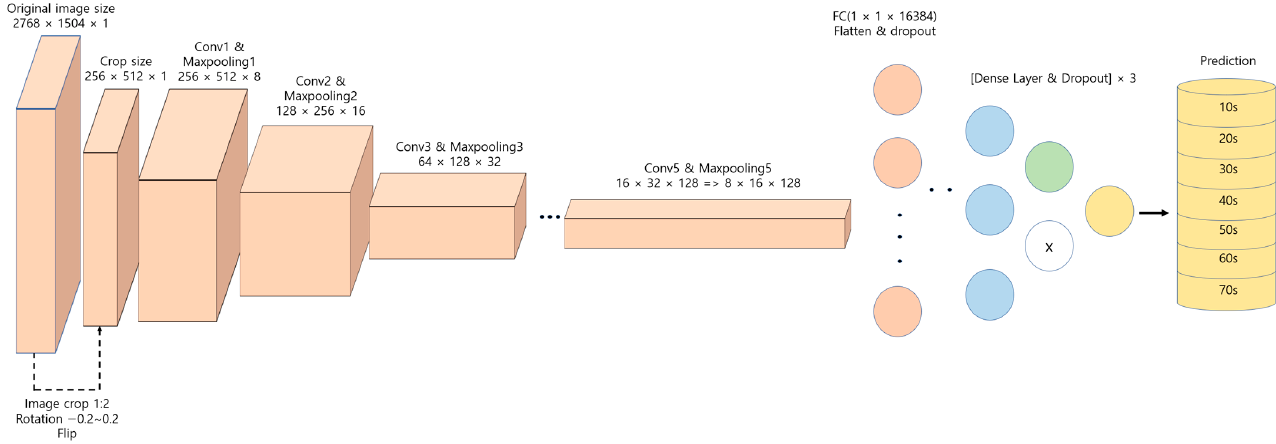
Figure 1. Network architecture of the proposed AI model.